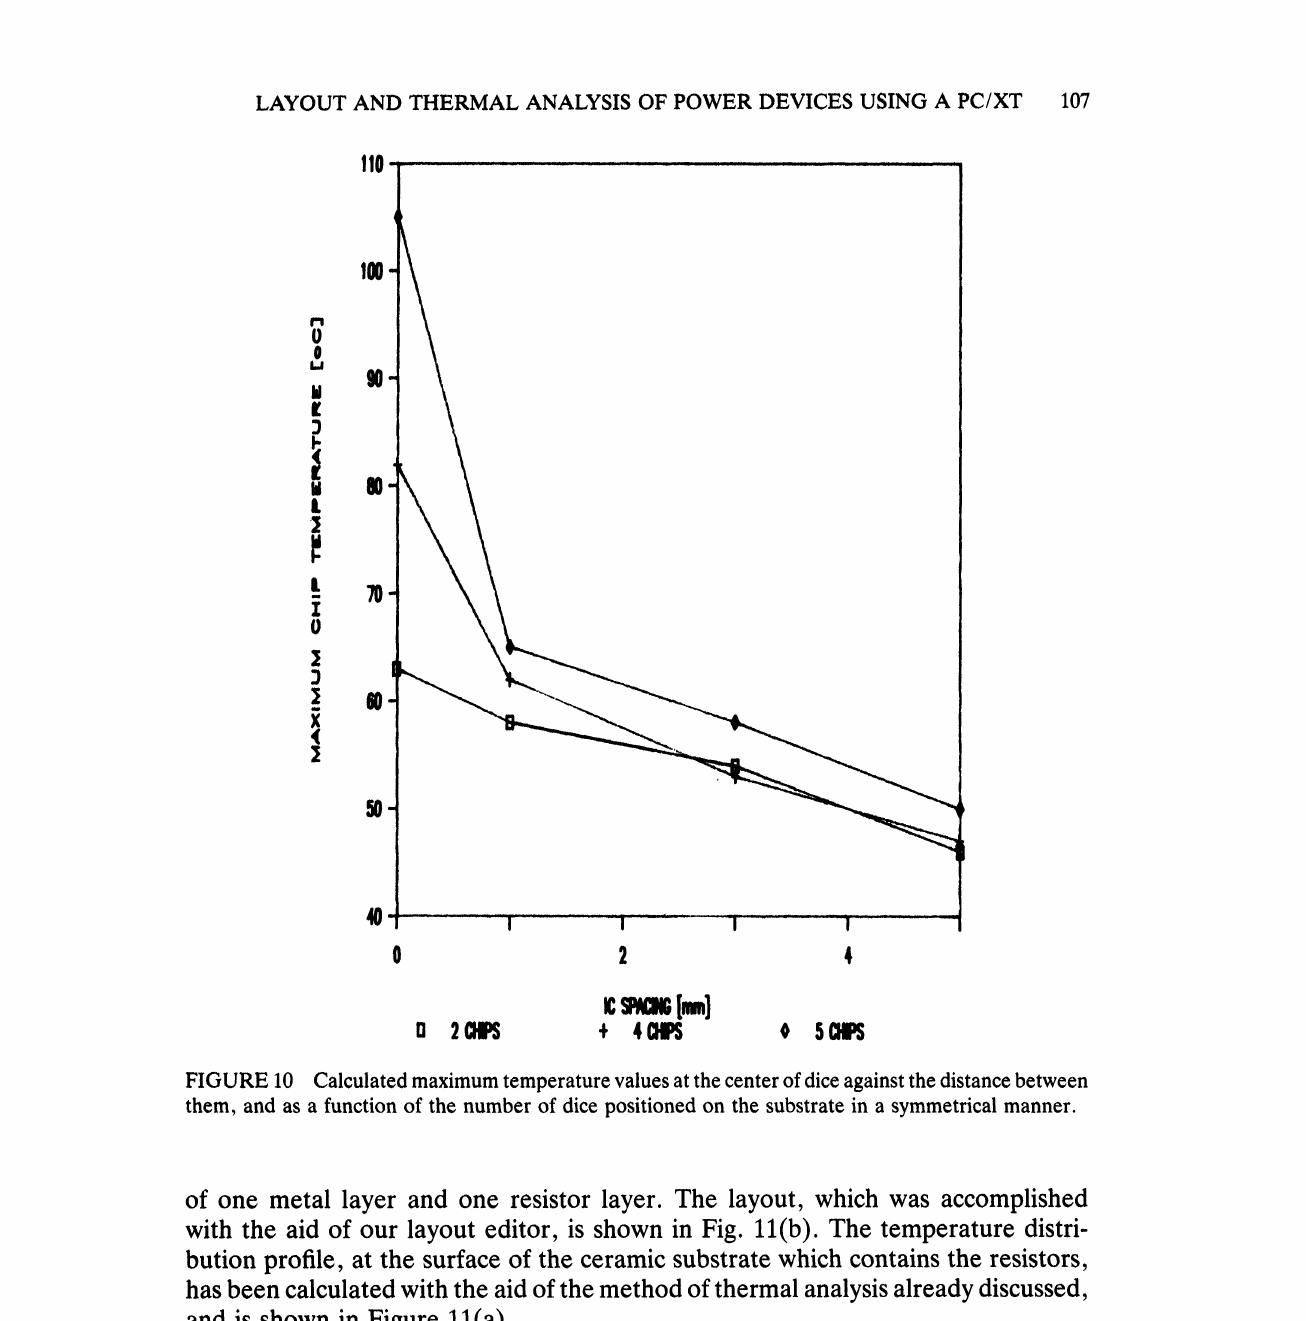
FIGURE 10 Calculated maximum temperature values at the center of dice against the distance between them, and as a function of the number of dice positioned on the substrate in a symmetrical